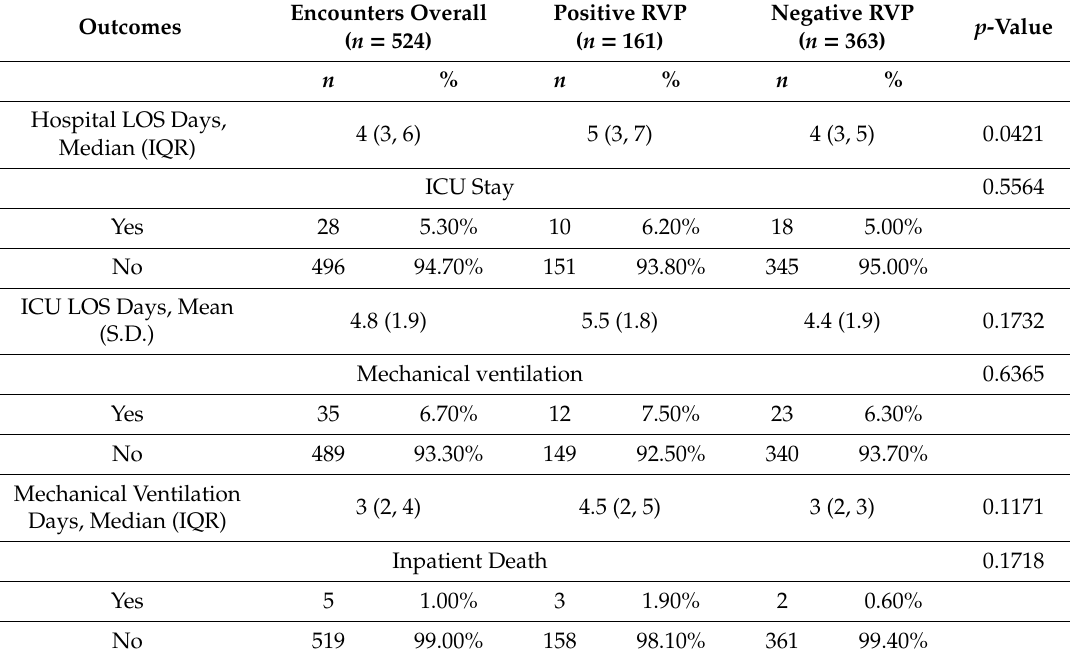
Table 2. Outcomes for all encounters by the positive and negative viral panel.